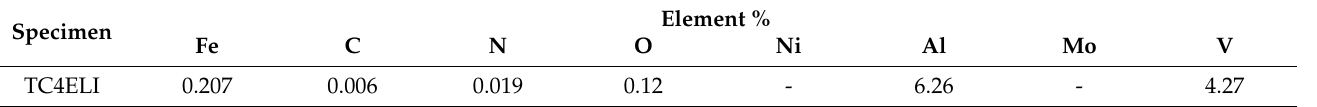
Table 2. Element composition of TC4ELI bar.